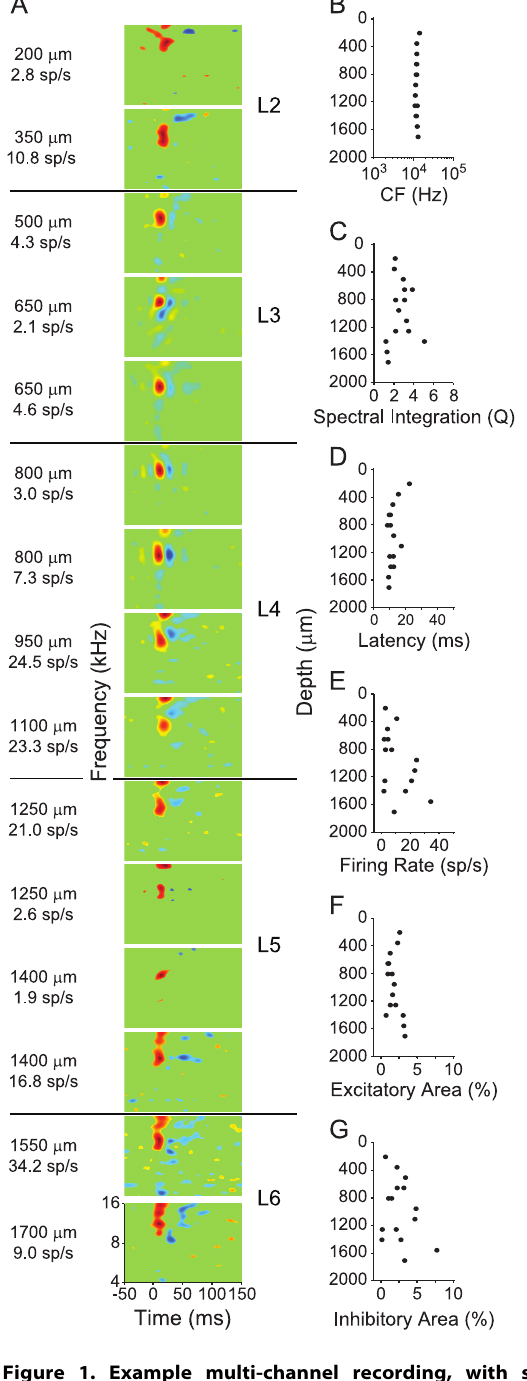
Figure 1. Example multi-channel recording, with spectro- temporal receptive fields (STRFs) and response parameters. (A) STRFs from simultaneously recorded columnar neurons in AI. Each row represents a single neuron. The cortical depth and firing rate of each neuron are indicated to the left of the STRFs. STRFs with the same depth values indicate that multiple neurons were recorded from the same electrode channel. (B) Characteristic frequency (CF) from the excitatory subfield of the STRFs. (C) Spectral integration, or quality factor (Q), of the excitatory subfield of the STRFs. (D) Peak excitatory latency in the STRFs. (E) Firing rate over the ripple stimulus duration. (F) STRF excitatory area percentage, or proportion of pixels, in the STRFs that were excitatory. (G) STRF inhibitory area percentage. Excitatory and inhibitory area percentages were determined by dividing the number of excitatory or inhibitory pixels by the total number of STRF pixels.